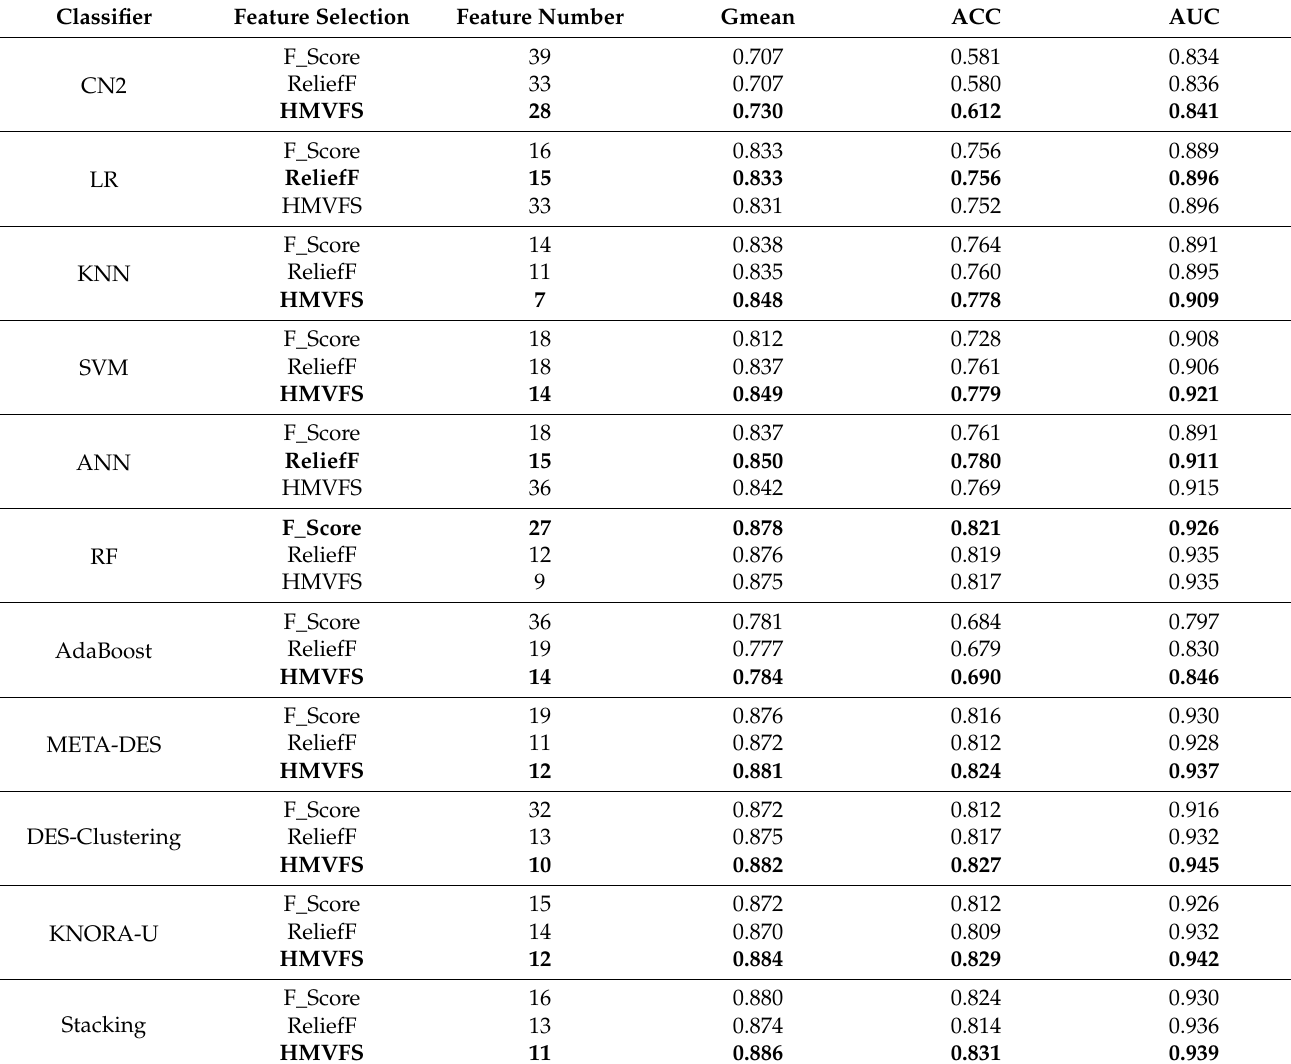
Table 3. Best performance comparison with different ML